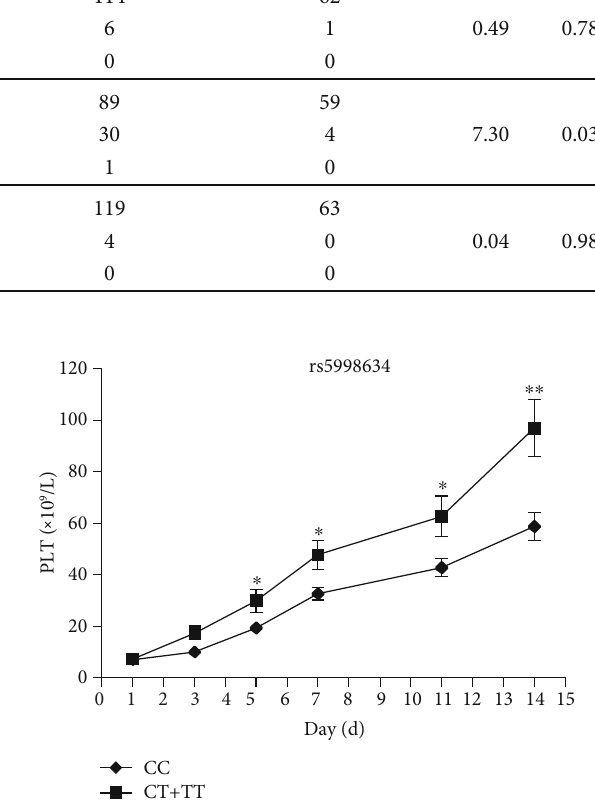
Figure 4: Association of the allele T of rs5998634 with the change of platelet count focus on the ITP patients treated with glucocorticoid. The mean platelet count of 148 ITP patients with CC genotype ( ● ) and 35 patients with CT or TT genotype ( ■ ) was calculated after treated with glucocorticoid at di ff erent time points: 1, 3, 5, 7, 11, and 14 days. ∗∗ P < 0 : 01 , ∗ P < 0 : 05 . Data represent mean ± SD . ( n = 148 in CC genotype group, n = 35 in CT or TT genotype